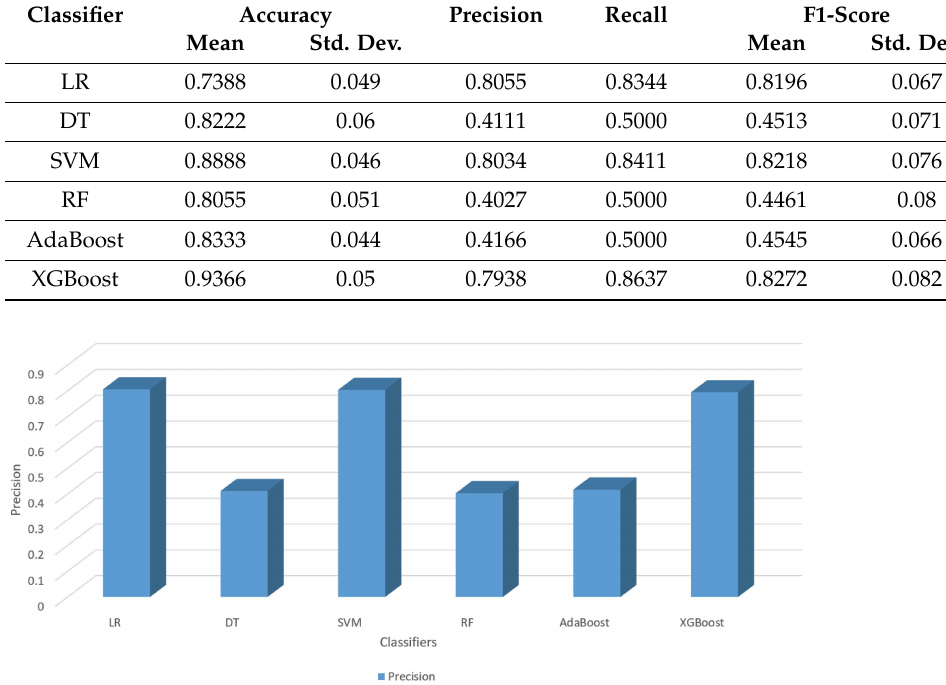
Figure 4. Evaluation results for the classifiers